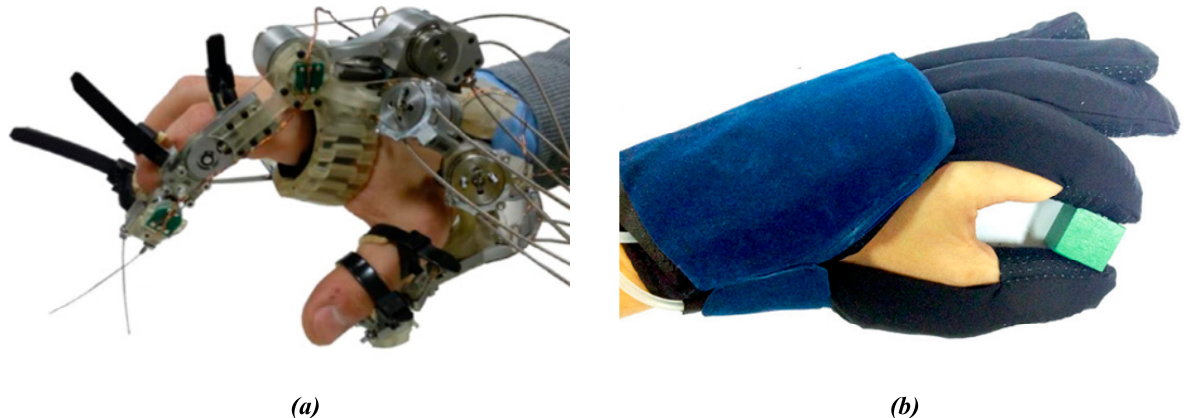
Figure 1. Flexible driving gloves. ( a ) HX- β ; ( b ) Soft robot gloves.